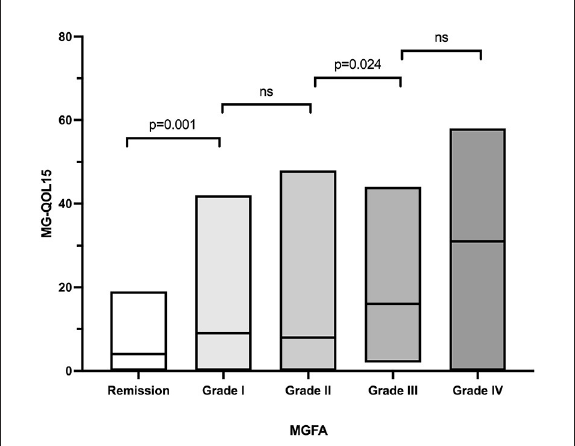
FIGURE3 The MGFA grade and MG-QOL15. ns, no significance; MGFA, Myasthenia Gravis Foundation of America; MG-QOL15, the 15-item Myasthenia Gravis Quality of